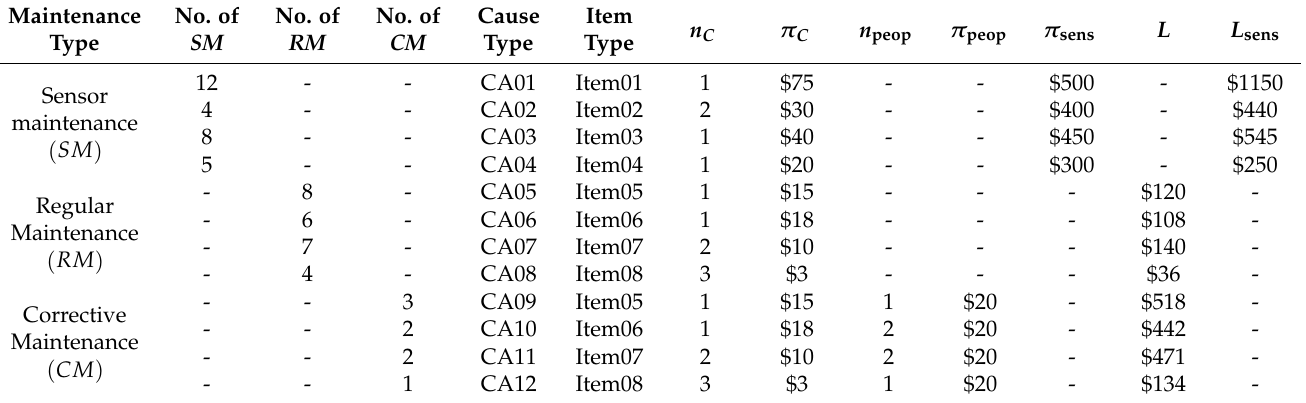
Table 4. Results of the EL-FMEA simulation for case